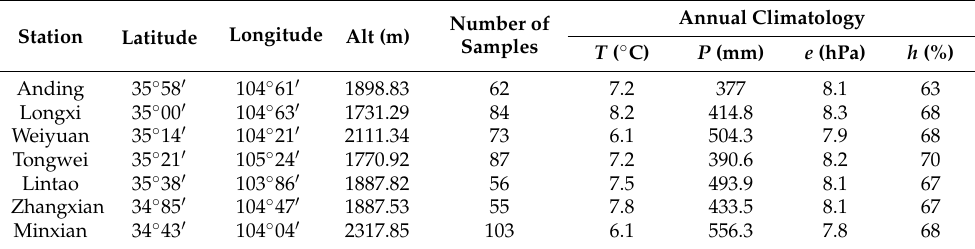
Table 1. Latitude, longitude, altitude, and annual climatology ( T -air temperature, P -precipitation amount, e -vapor pressure, and h -relative humidity) during 1981–2010 at the sampling stations. Station